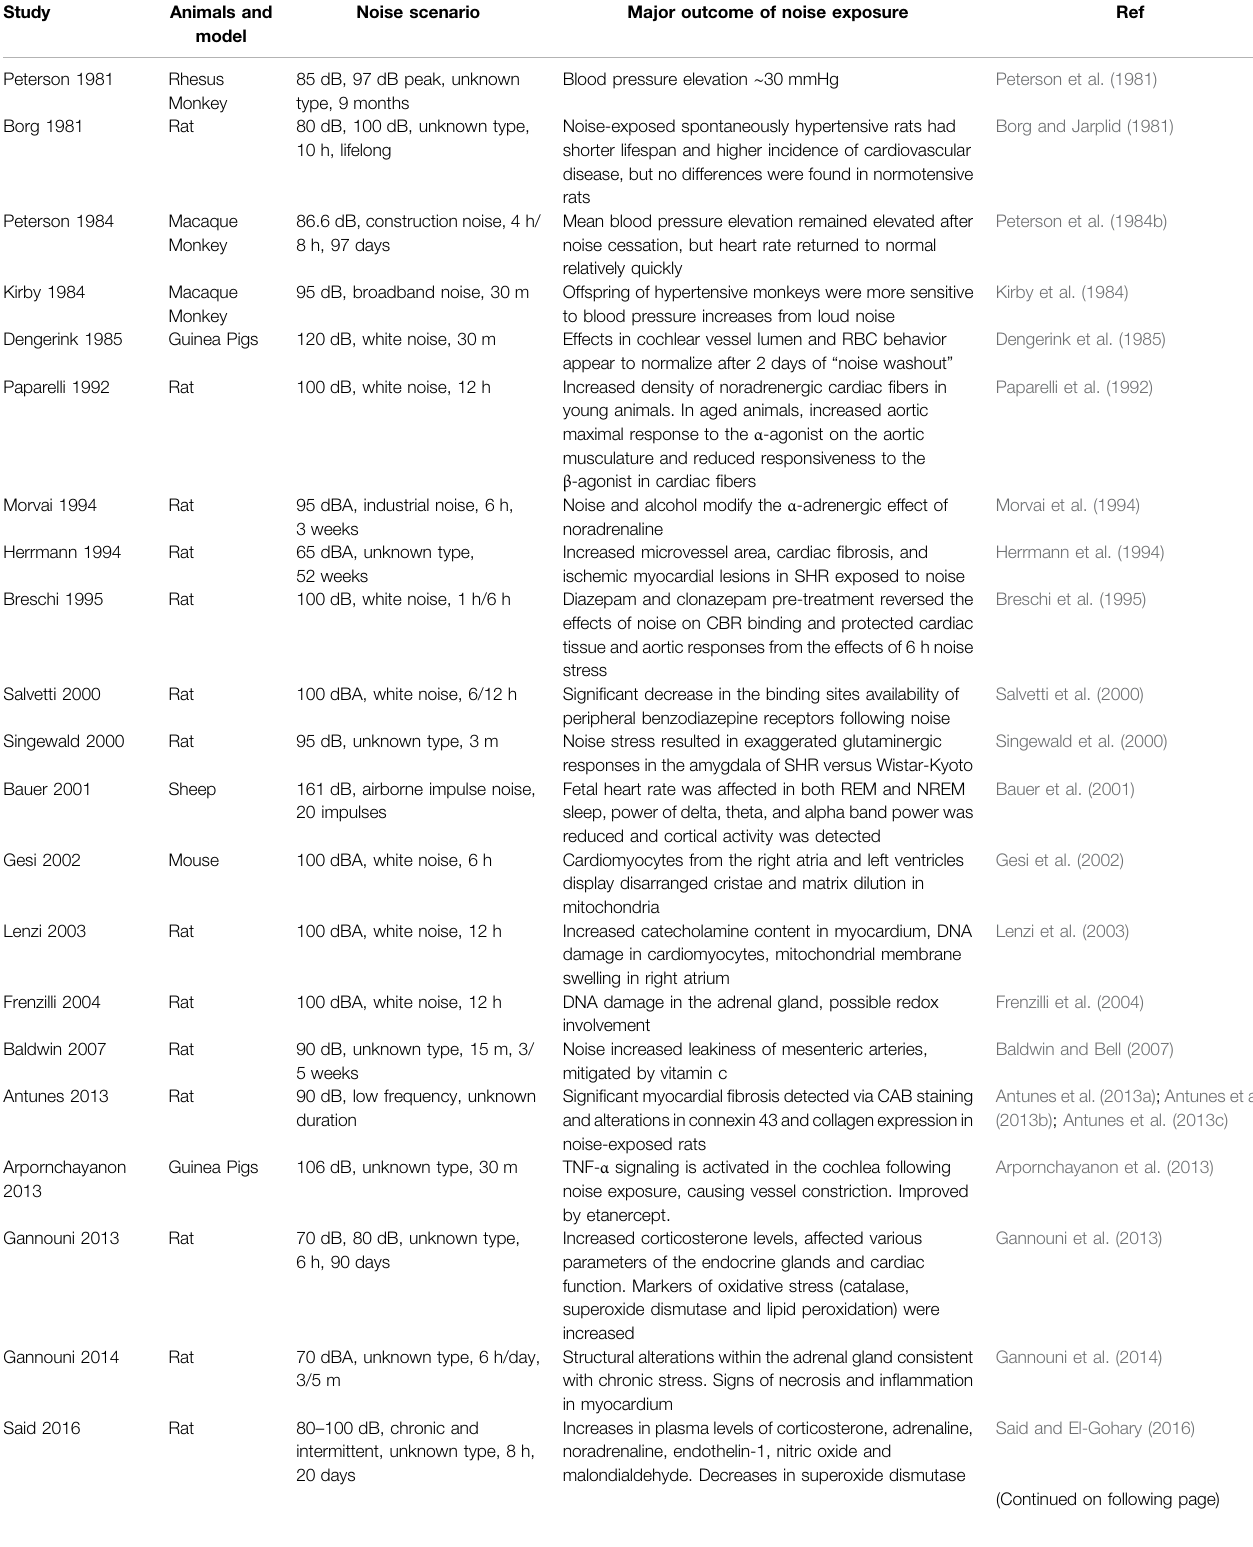
TABLE 1 | Studies on non-auditory noise effects on cardiovascular and endothelial dysfunction, in fl ammation or oxidative stress in animals a . Only articles that are not discussed in detail in the main article text are listed